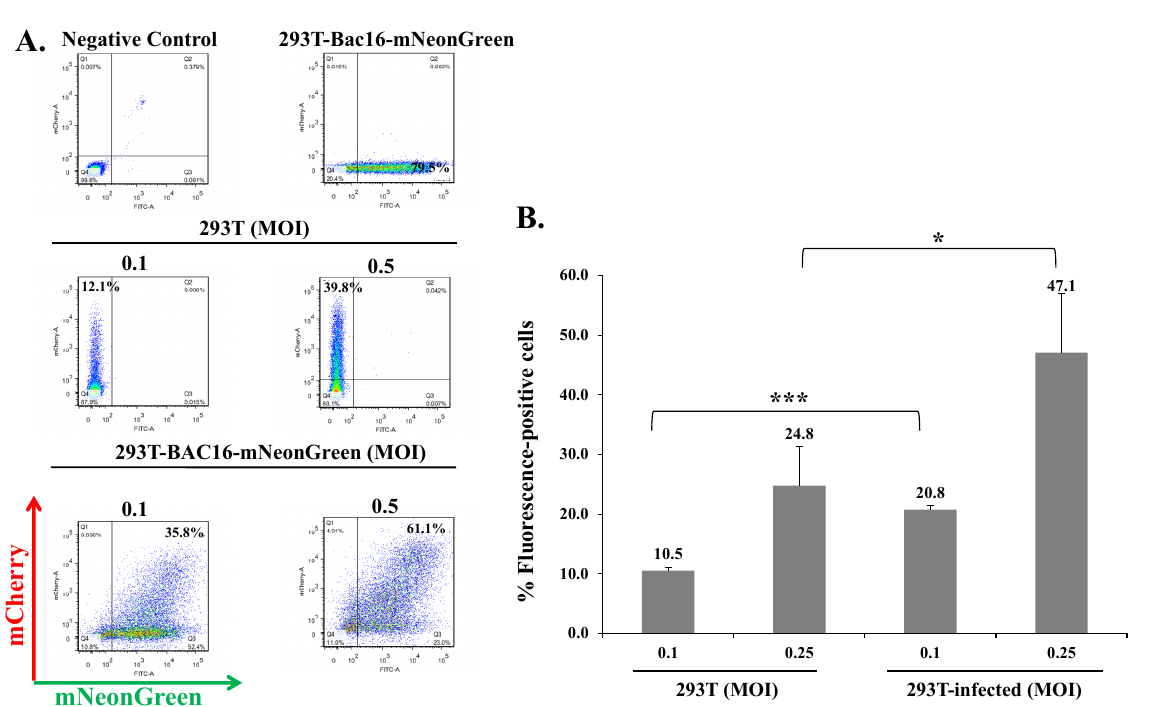
Figure 3. KSHV-infected HEK-293T cells can be superinfected and display enhanced expression of the fluorescent marker of the incoming virions. ( A ) Naive HEK-293T cells and latently infected HEK-293T cells that carry BAC16-mNeonGreen were seeded in six-well plates (500,000 cells per well). The next day, the cells were infected with BAC16-mCherry viruses at MOIs of 0.1 and 0.5 using spinoculation. After 48 h, the cells were harvested, and the percentages of cells expressing mNeonGreen and mCherry were measured by FACS. ( B ) Percentage of cells expressing the fluorescent protein (mNeonGreen/mCherry) encoded by the incoming viral genome. 293T—naive uninfected cells, 293T-infected-latently 293T-infected cells that were re-infected. Results shown are averages of three independent experiments. Statistical analysis was carried out using Tukey’s post hoc analysis test. *** p < 0.001, * p < 0.05. Naive uninfected HEK-293T cells were used as a negative control, while BAC16-mCherry and iSLK-BAC16-mNeonGreen-infected HEK-293T cells served as positive con- trols.